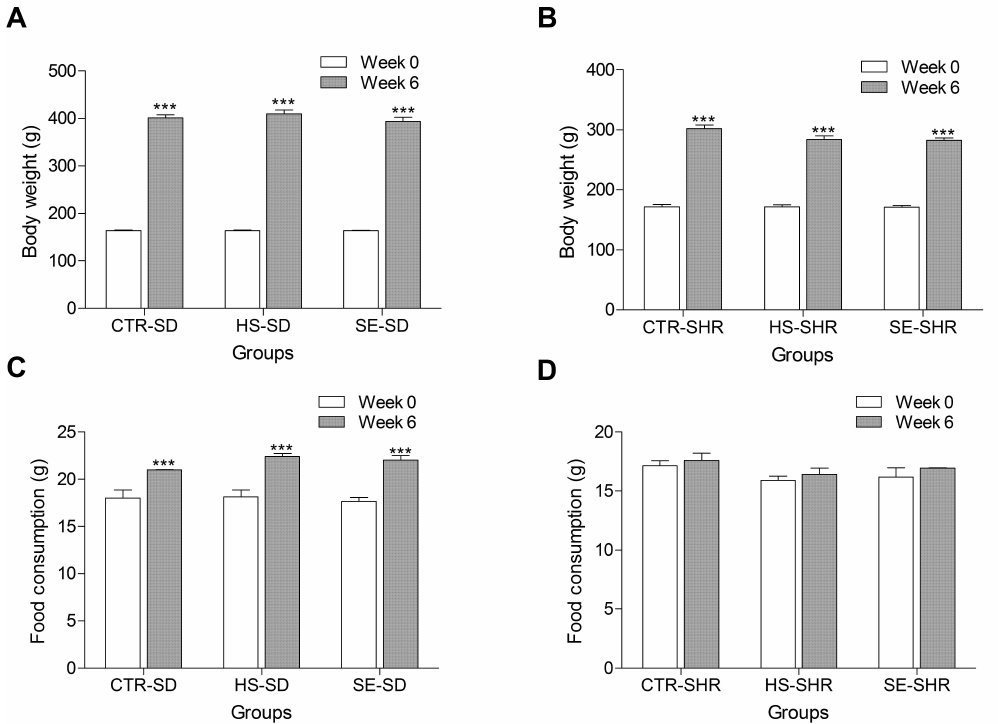
Figure 4. Body weight ( A , B ) and food consumption ( C , D ) were examined in spontaneously hypertensive rats ( B , D ) and Sprague–Dawley ( A , C ) rats fed high edible salt and Salicornia europaea extracts (SE) for six